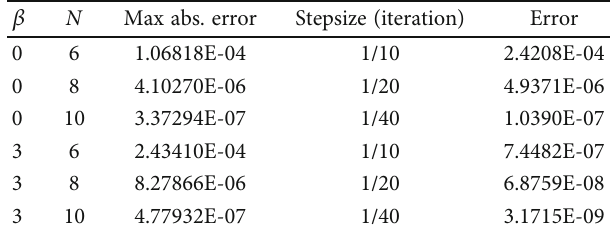
Table 4: Relative absolute errors obtained by proposed method with N = 6, 8, 10 for Example 4. x Exact solution RAE ( N = 6 ) RAE ( N = 8 ) RAE ( N = 10